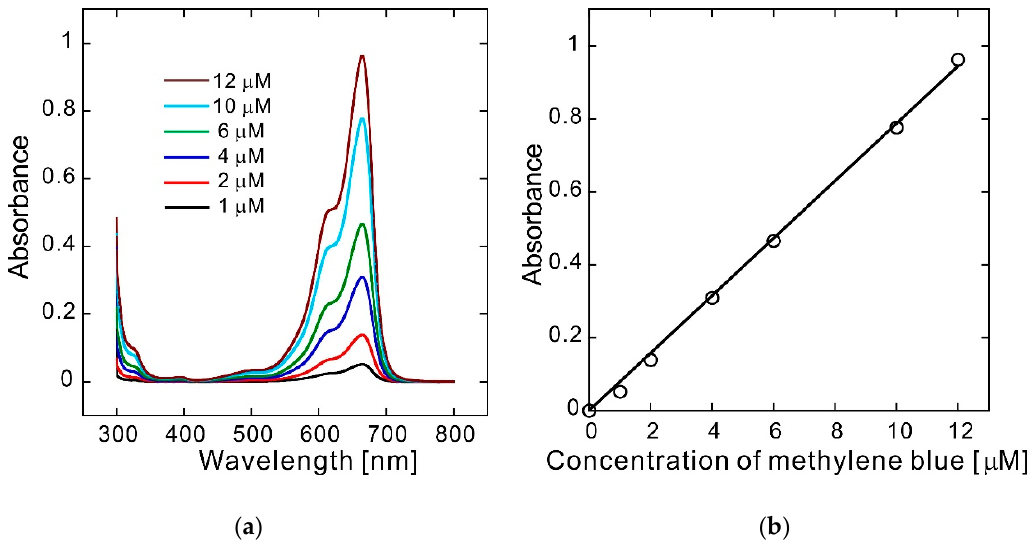
Figure 3. ( a ) UV/vis absorbance spectra of methylene blue and ( b ) absorbance at 664 nm as a function of concentration.